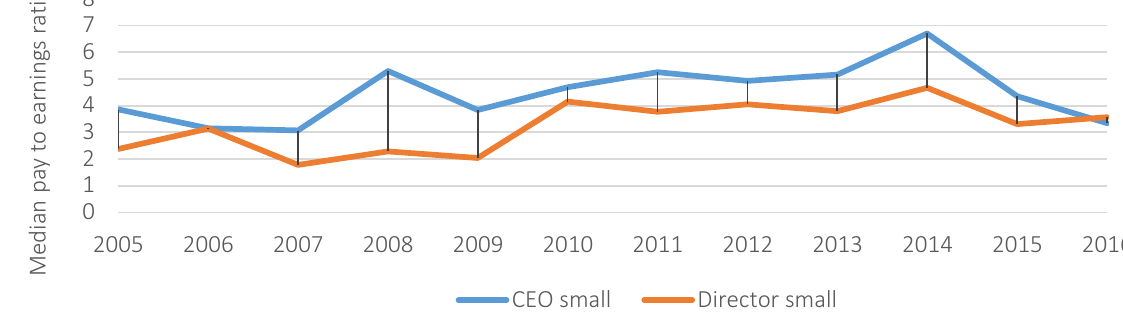
Figure 5. Pay to earnings ratio in small